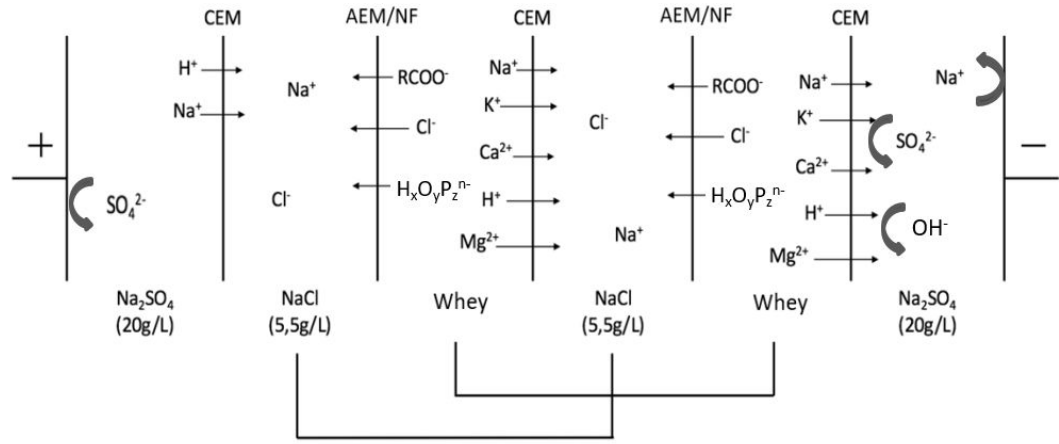
Figure 7. Scheme of ionic migration during ED